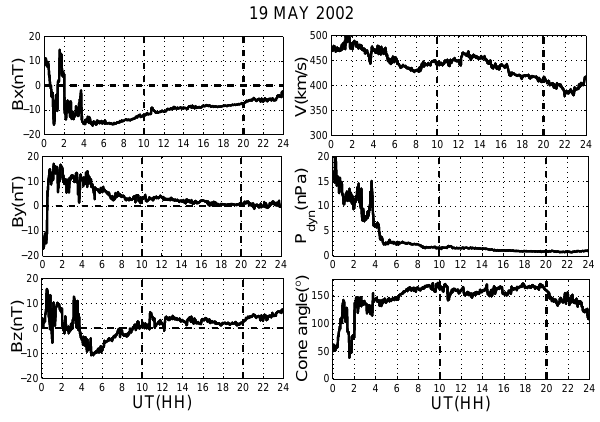
Figure 1. Temporal variations in solar wind and IMF parameters observed by the ACE satellite on 19 May 2002; these were time- shifted to the bow shock. The left panels show the IMF components B x , B y , B z in the GSM coordinate system, and the right panels show the solar wind speed (V), dynamic pressure ( P dyn ) and IMF q B 2 x + B 2 y + B 2 z ) . The RIMF interval lasts cone angel, arccos ( B x / for 10h from 10:00UT to 20:00UT, as indicated by the vertical dashed line.